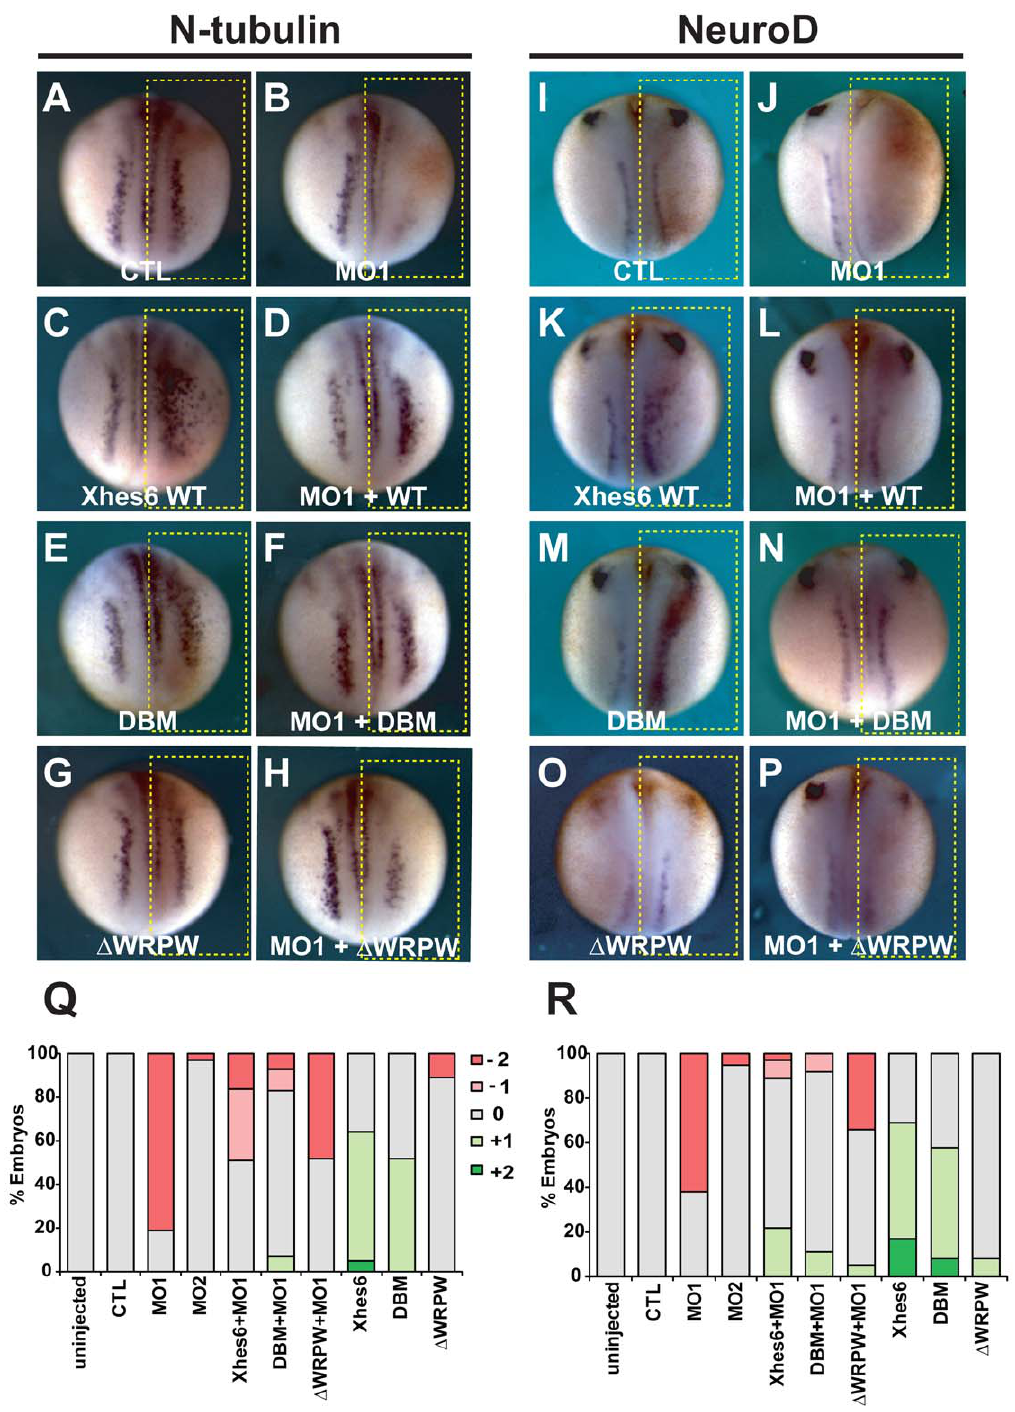
Figure 2. Xhes6 expression is required for neural differentiation. Whole mount in situ hybridization of neurula stage embryos for neural markers neural b -tubulin ( N-tubulin , A-H) or NeuroD (I-P). A, B, I, J: One cell of two cell stage embryos was injected with control (CTL, A, I) or Xhes6 (MO1, B, J) morpholinos along with b -gal tracer mRNA (red staining). Injection of MO1 decreases both N-tubulin and NeuroD expression on the injected side (yellow box). C-H, K-P: Rescue of MO1 phenotype. 500 pg of mRNA encoding wild type Xhes6 or DNA binding domain (DBM) or Groucho binding domain, ( D WRPW) mutants was injected with or without MO1. Overexpression of Xhes6 (C, K) or DBM (E,M) alone enhances neural differentiation, both Xhes6 and DBM rescue neural maker expression in Xhes6 morphants (D, F, L, N). The D WRPW mutant has minimal effect when injected alone (G, O) and is less efficient in rescuing the MO1 phenotype. Q,R quantitation of phenotypes observed, scored as in Fig. S2, Q, N-tubulin mRNA expression, corresponding to panels A-H, R, NeuroD mRNA expression, corresponding to panels I-P. Full data on the frequency of phenotypes and the number of embryos analyzed is given in Table 1.